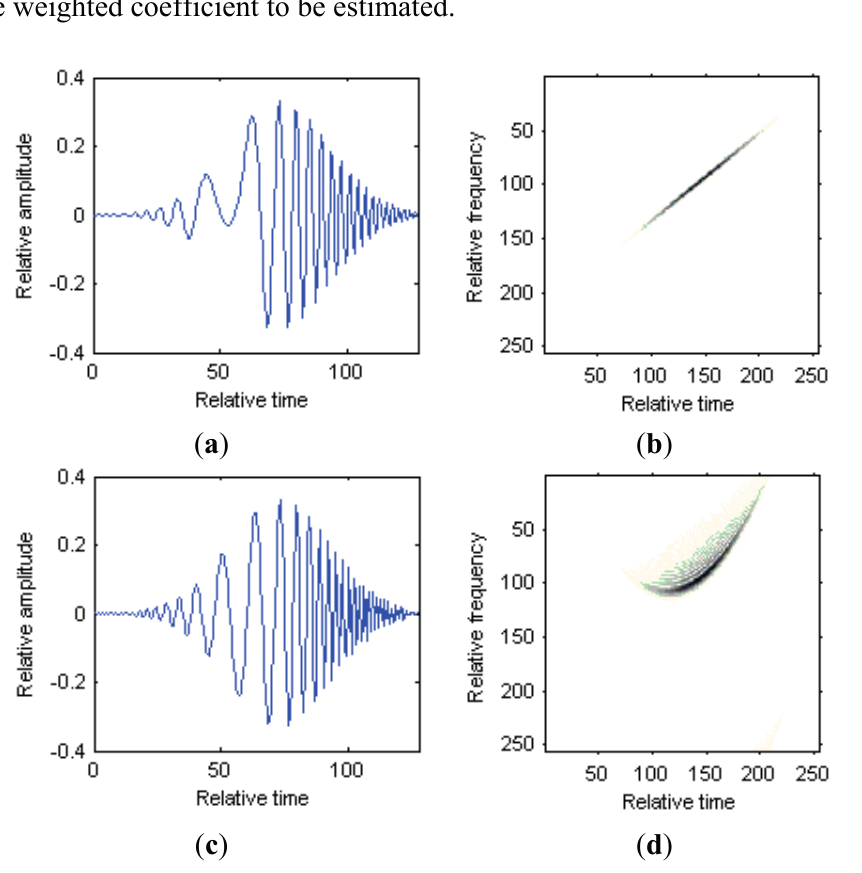
Figure 2. Comparison between Chirplet atom and modified version of Chirplet atom. ( a ) Time series for the Chirplet atom; ( b ) WVD for the Chirplet atom; ( c ) Time series for the modified version of Chirplet atom; ( d ) WVD for the modified version of Chirplet